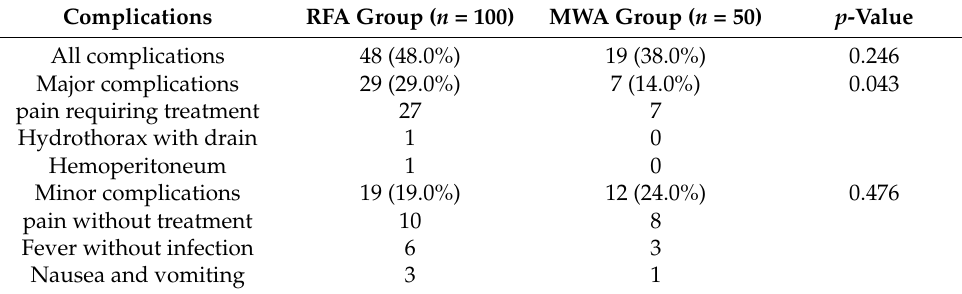
Table 2. Comparison of treatment complications between RFA and MWA in the entire population.